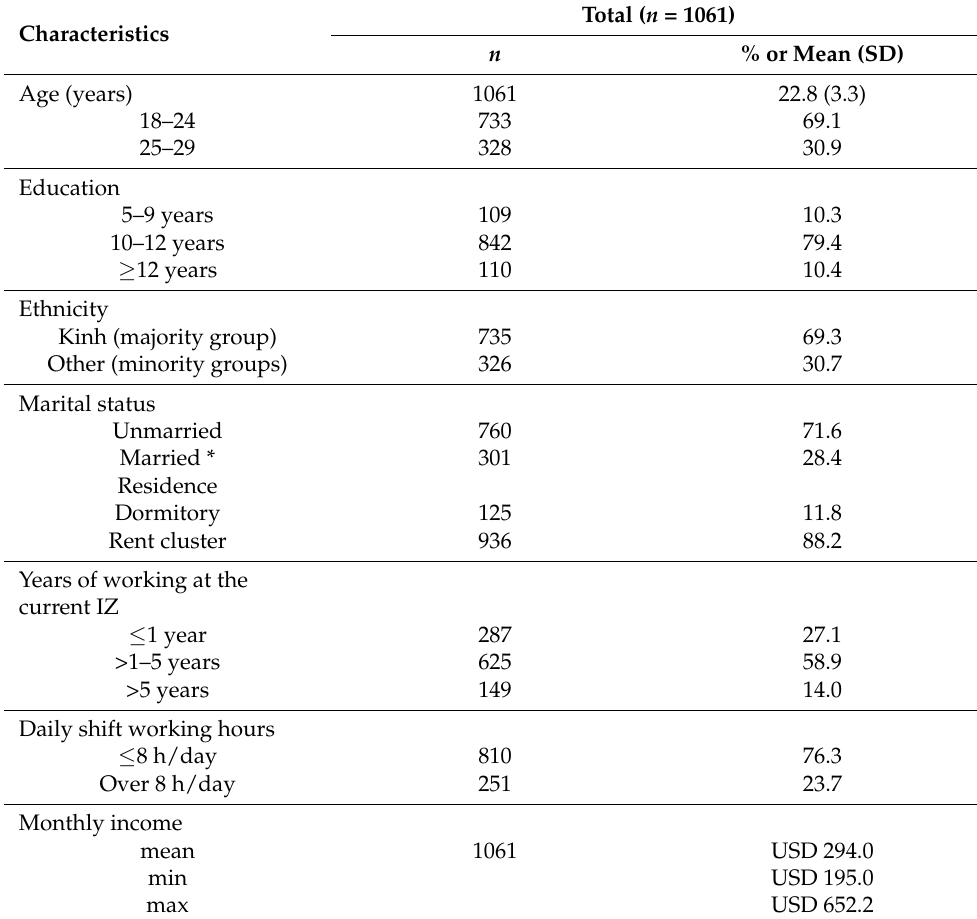
Table 1. Participant characteristics.